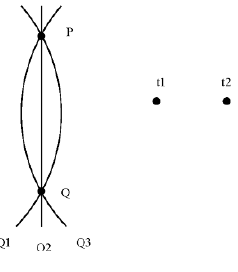
Figure 5. The critical points of